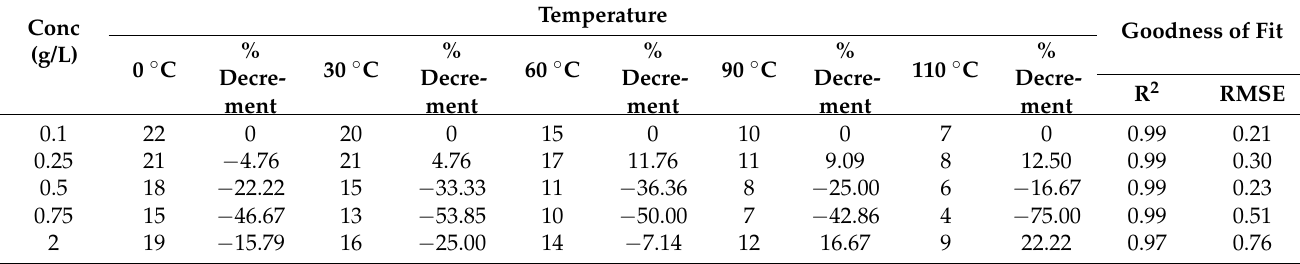
Table 6. Variation of kinematic viscosity (cSt) of MO under the influence of Al 2 O 3 concentration and temperature with 95%